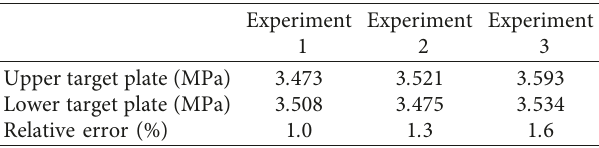
Figure 8: Pressure-time profiles of the upper and lower target plates of the other two experiments. Table 2: The relative errors between the upper and lower target plates’ peak pressure of these three